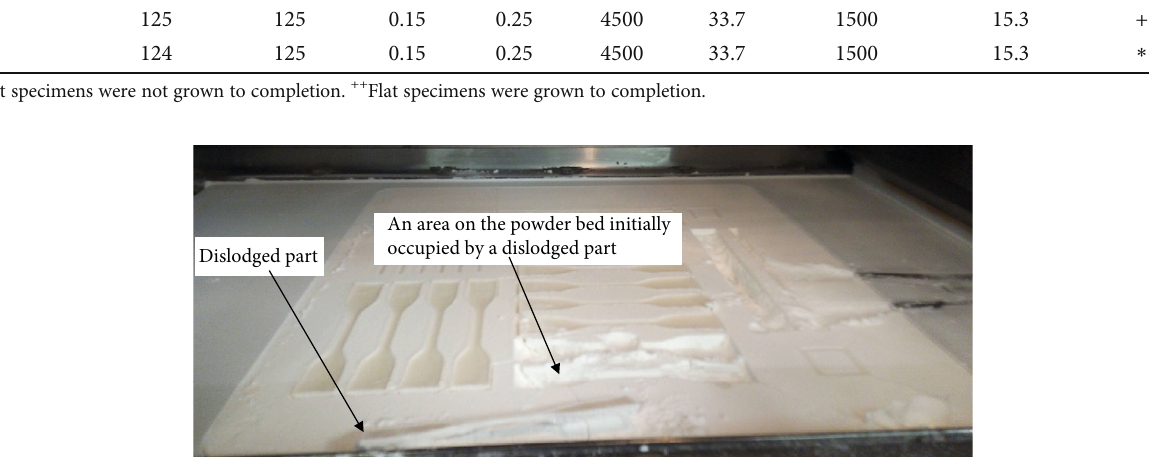
Figure 4: Printed parts on the powder bed, showing minimal curling visible on the edges and parts dislodged from their positions by the recoater blade. Table 6: Some mechanical properties of the built test specimens. Elastic Specimen